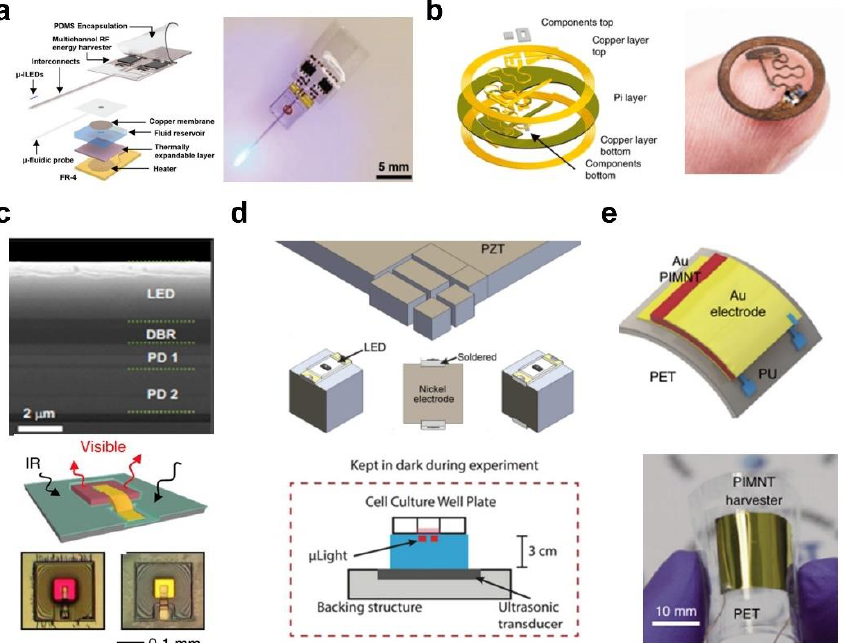
Figure 5. Wireless power transfer strategies for implantable and battery-free devices. The miniaturized implantable and wearable optoelectronic devices are powered by the following: ( a ) the subcutaneous coils based on far-field radiofrequency. Reproduced with permission from Ref. [95]. Copyright 2018, Small. ( b ) Magnetic resonant coupling power delivery. Reproduced with permission from Ref. [4]. Copyright 2018, Nature Electronics. ( c ) Photovoltaic conversion of near-infrared light. DBR, distributed Bragg reflector; PD, photovoltaic diodes. Reproduced with permission from Ref. [25]. Copyright 2018, PNAS. ( d ) An ultrasonic transducer. Reproduced with permission from Ref. [9]. Copyright 2019, Scientific Reports. ( e ) A flexible piezoelectric energy harvester. PET, polyethylene terephthalate; PIMNT, Pb(In 1/2 Nb 1/2 )O 3 – Pb(Mg 1/3 Nb 2/3 )O 3 – PbTiO 3 ; PU, polyurethane. Reproduced with permission from Ref. [99]. Copyright 2021, Nature Biomedical Engineering.